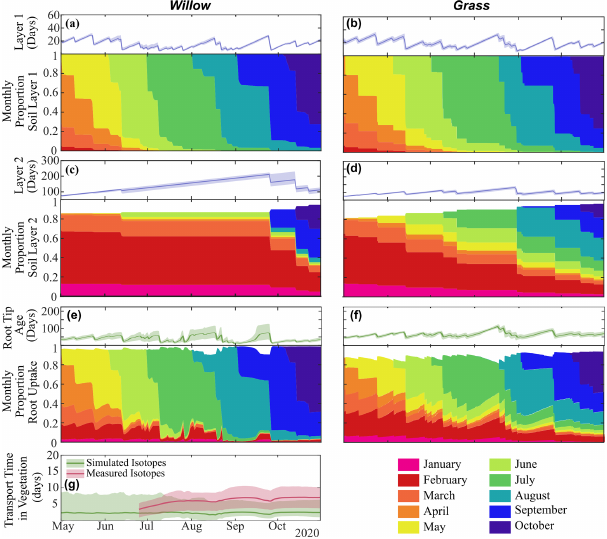
Figure 7. Average water age (and range) and fractional monthly water contribution in layer 1 (10cm) in (a) Willow 1 and (b) grass and in layer 2 (40cm) in (c) Willow 1 and (d) grass; the average (and range) of water entering roots in (e) Willow 1 and (f) grass; and (g) the average (and range) of time between root uptake and 1m using distance-based mixing using simulated or measured soil water isotopes. Fractional water ages are shown in Fig. S5, and transit times from different soil layers are in Table